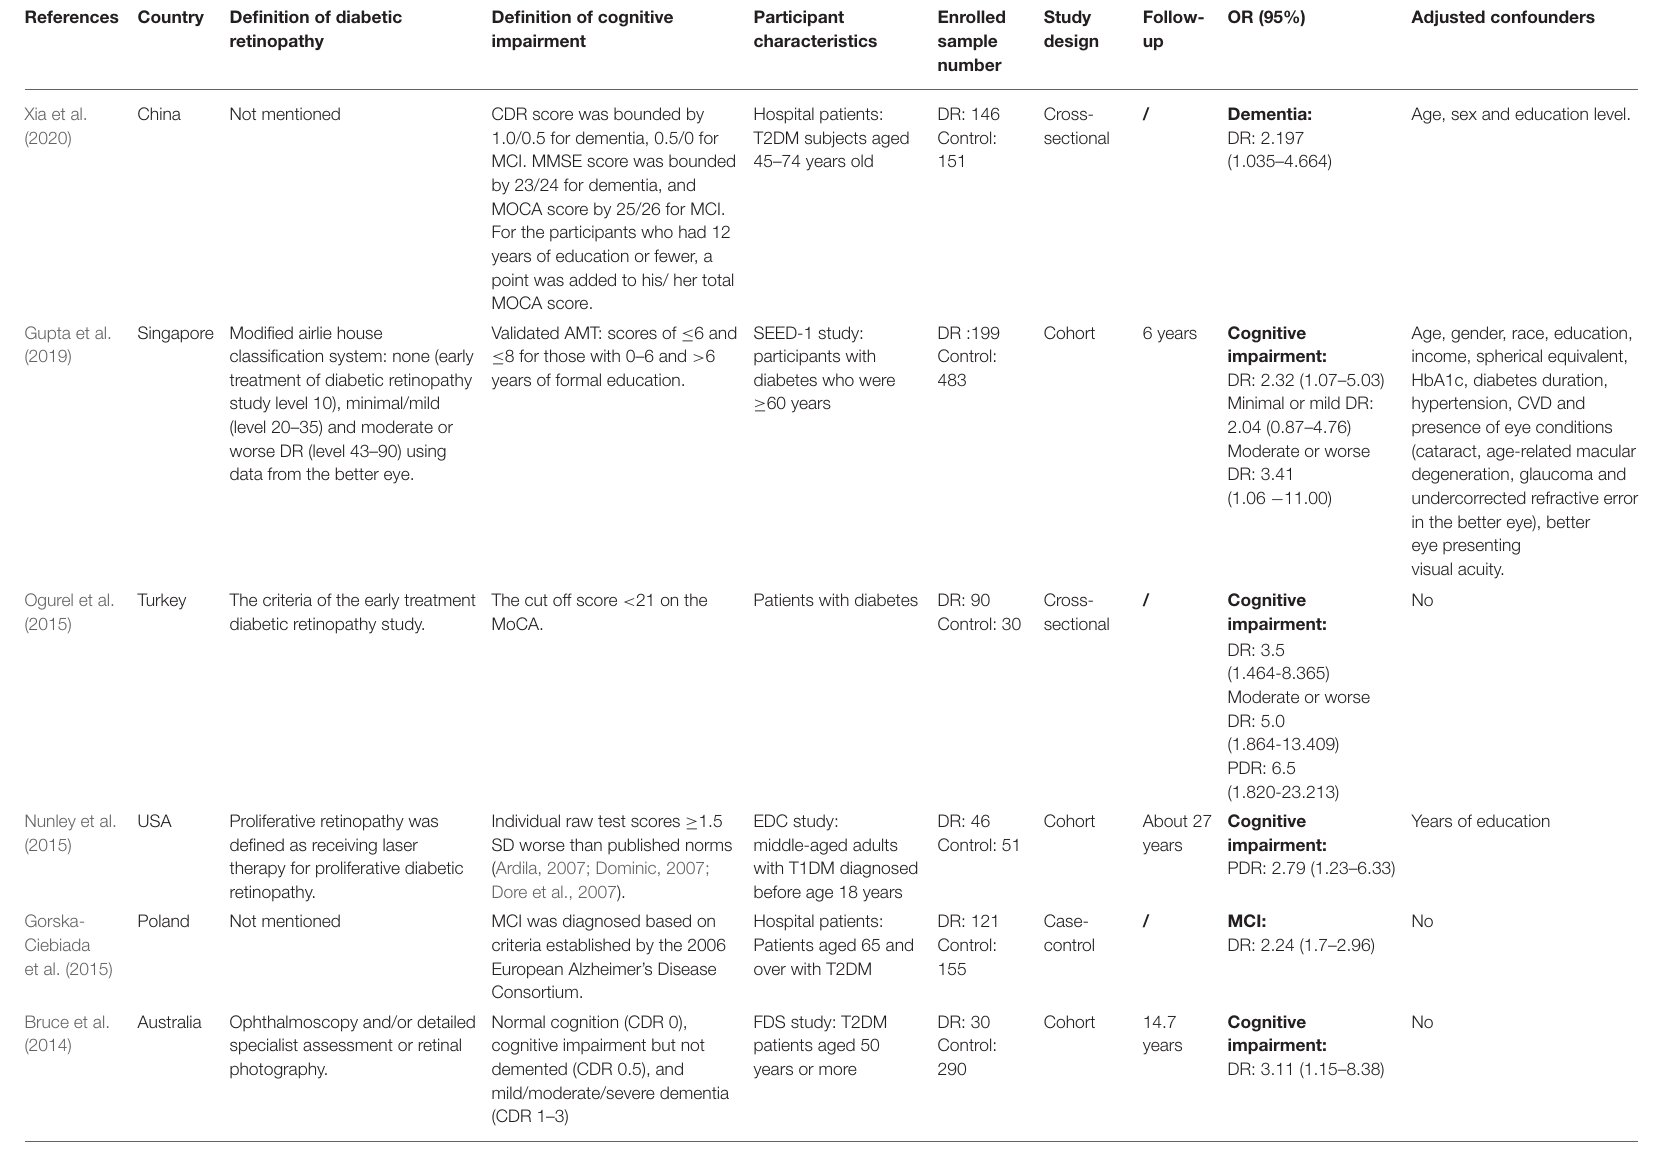
TABLE 1 | Characteristics of the study providing odds